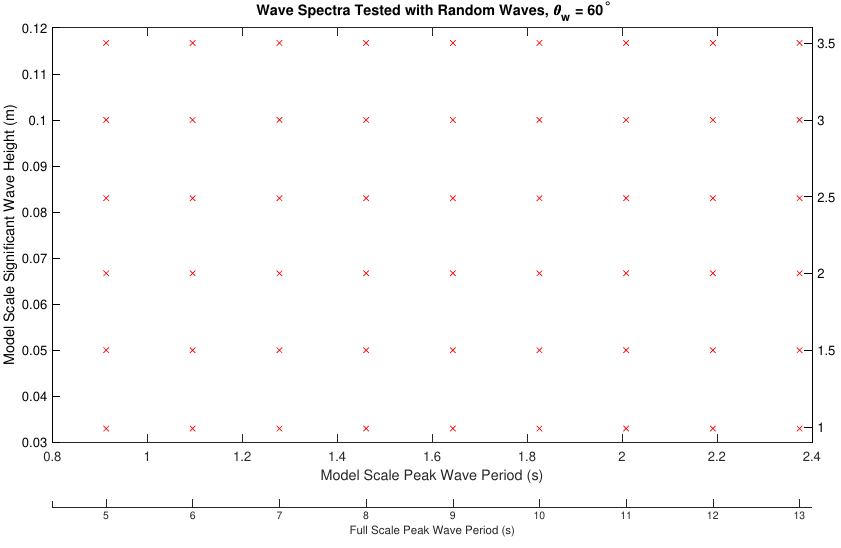
Figure 5. Random wave cases tested showing model scale values and full scale